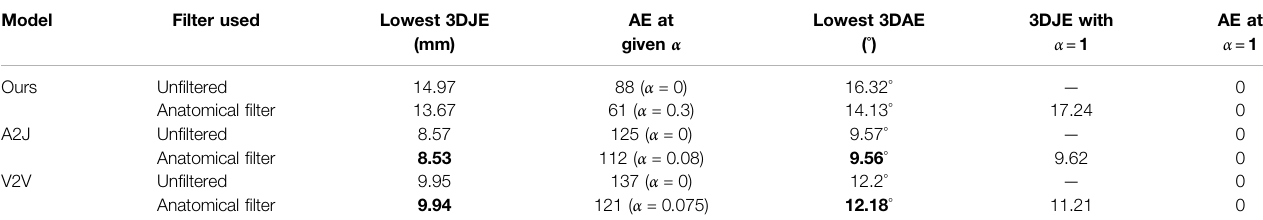
TABLE 3 | 3D Joint Errors (3DJE) and 3D Angle Errors (3DAE) derived from the HANDS2017 dataset with all the models. Bold values represent the lowest error in each column. Model